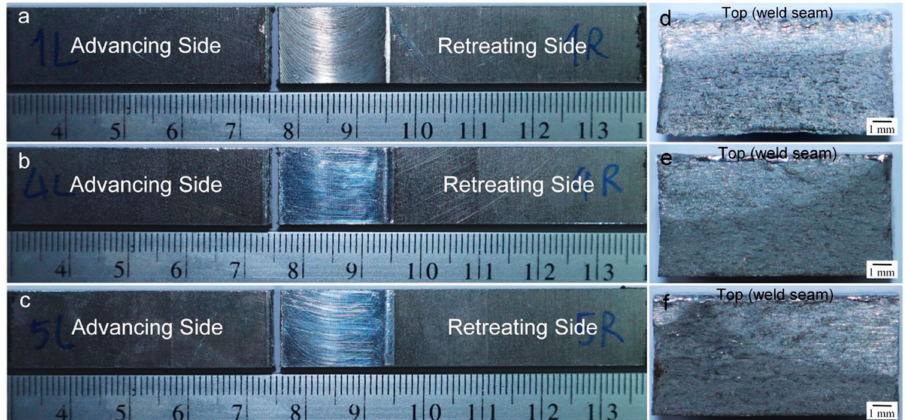
Figure 19. Photographs of the broken workpiece from fatigue testing ( a ) FSW; ( b ) FSW-DR-PWHT; ( c ) FSW-PWHT-DR; ( d ) cross section of FSW (advancing side); ( e ) cross section of FSW-DR-PWHT (advancing side); and ( f ) cross section of FSW-PWHT-DR (advancing